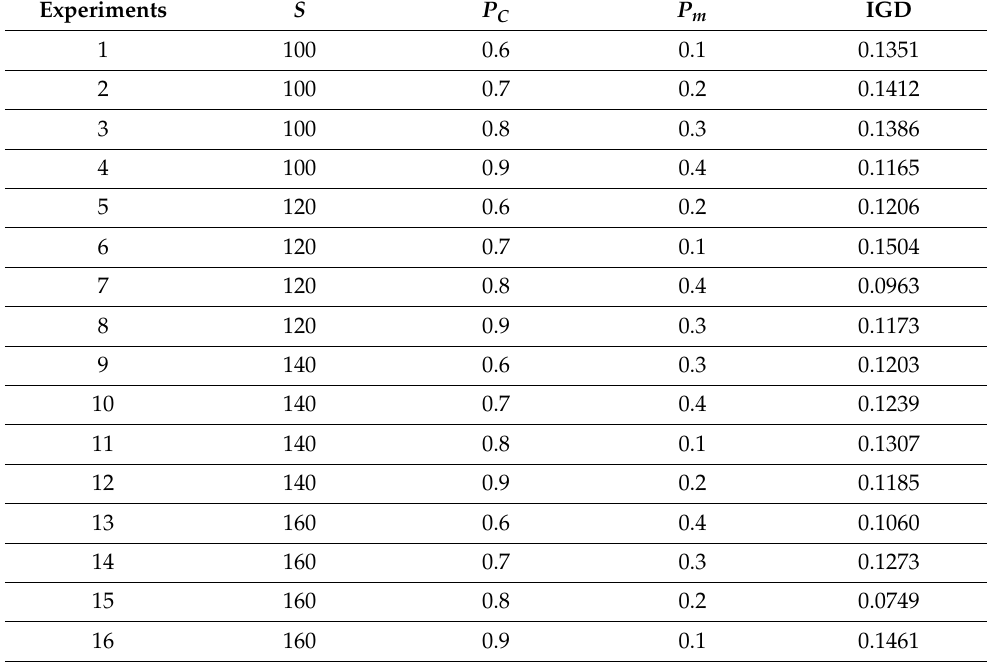
Table 2. The orthogonal array